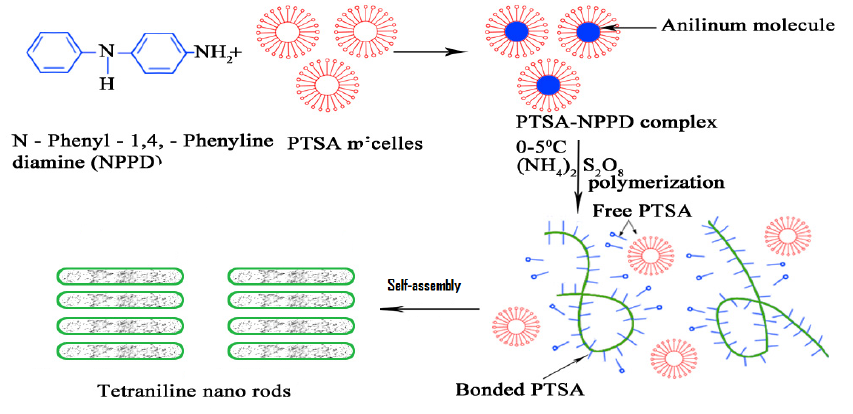
Figure 4. Schematic illustration of preparation of PTSA doped tetraaniline nanorods.